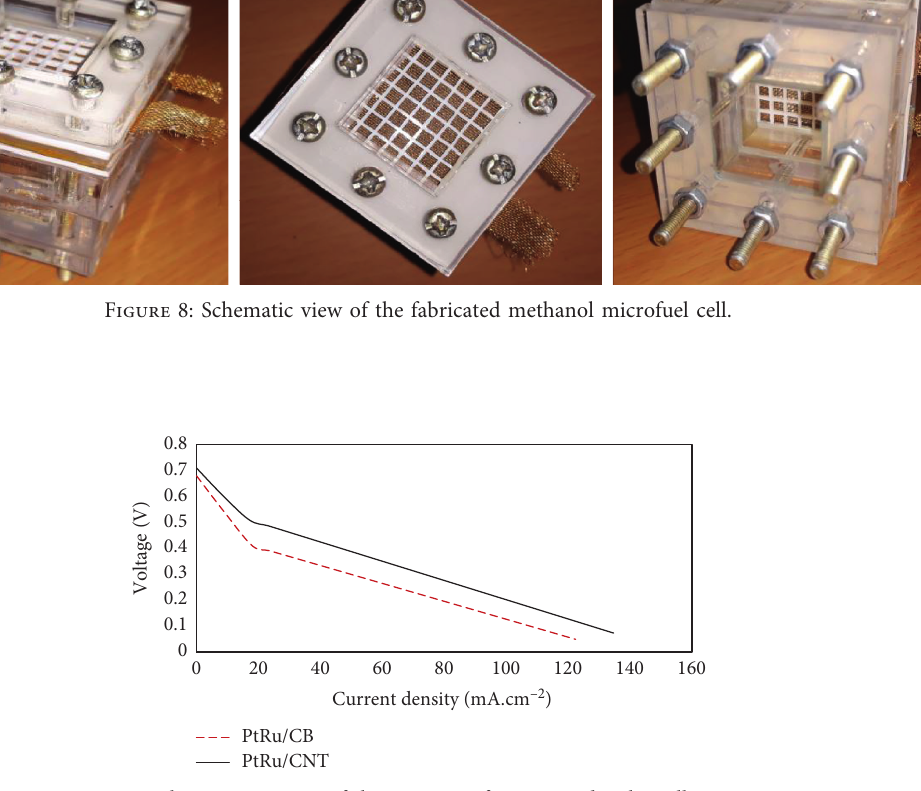
Figure 9: Polarization curves of the two sets of MEAs under the cell